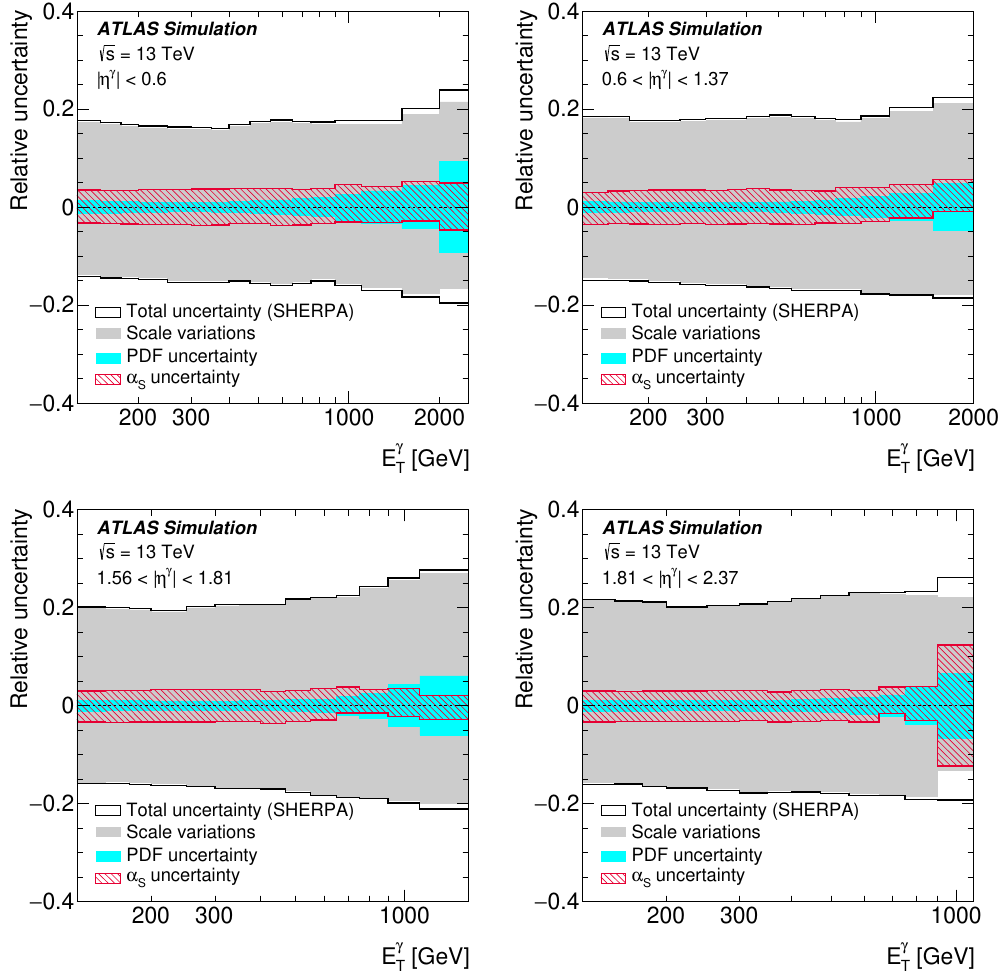
Figure 4 . The relative total theoretical uncertainty in the cross-section prediction of Sherpa 2.2.2 as a function of E (cid:13) in di(cid:11)erent regions of j (cid:17) (cid:13) j . The uncertainty from the scale variations, the T uncertainty from the PDFs and the uncertainty from the value of (cid:11) s are also included.